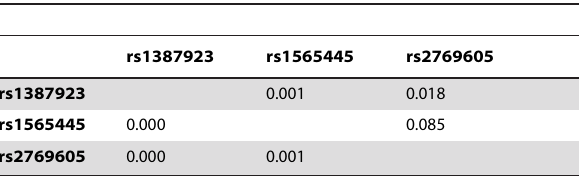
Table 1. Pairwise linkage disequilibrium results among SNPs in NTRK2 .